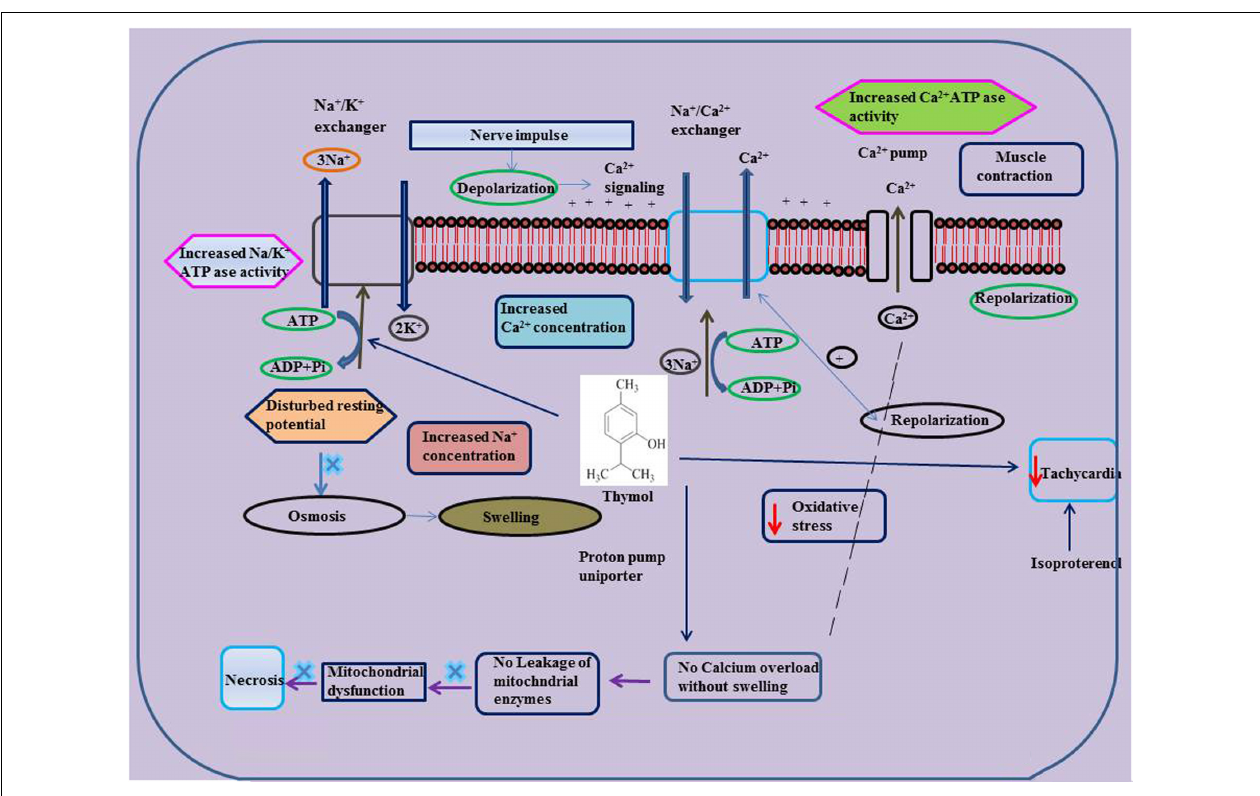
FIGURE 3 | Effect of thymol on ISO induced altered ionic homeostasis and mitochondrial